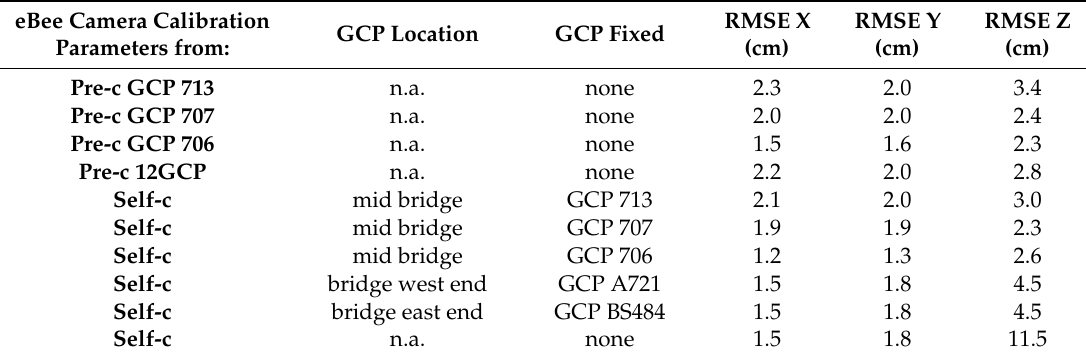
Table 6. Accuracy of the joint adjustment of the eBee and P4 30 blocks: RMSE on 44 CP coordinates. No GCP was fixed in the four BBA with pre-calibrated parameters, while self-calibration was executed with a single GCP fixed in all but the last case.